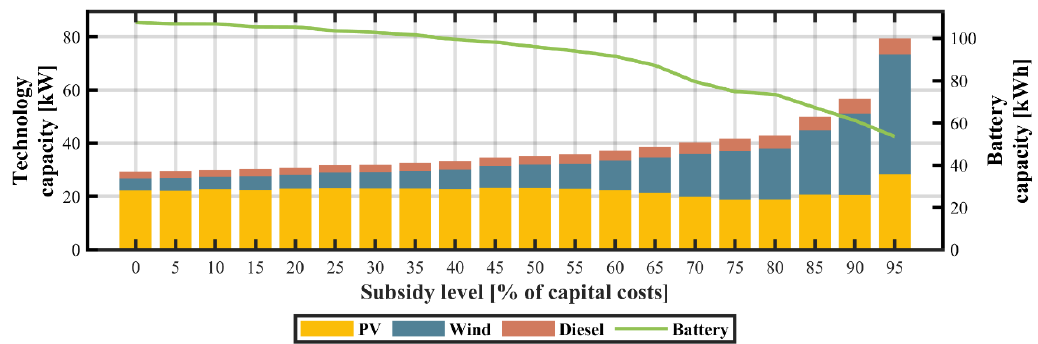
Figure 8. Simulation results of capital subsidies for renewable energy technologies. Impact on the capacity of DG technologies.